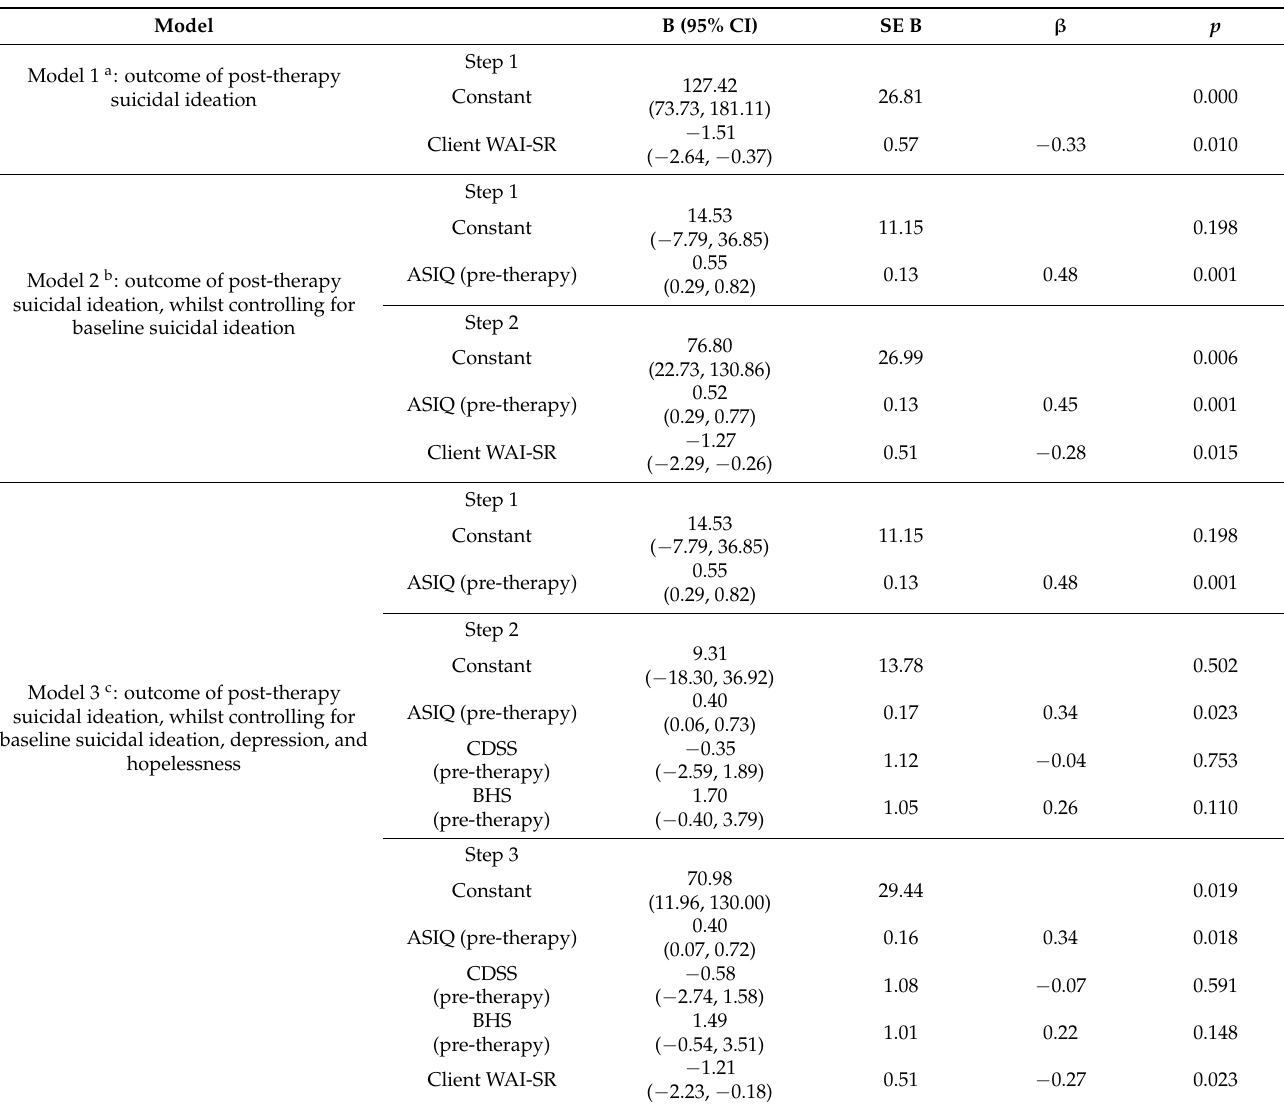
Table 3. Results of the hierarchical linear regression model examining the predictive relationship between the early therapeutic alliance and suicidal ideation post-therapy after controlling for suicidal ideation pre-therapy, depression, and hopelessness. Model Model 1 a : outcome of post-therapy suicidal ideation